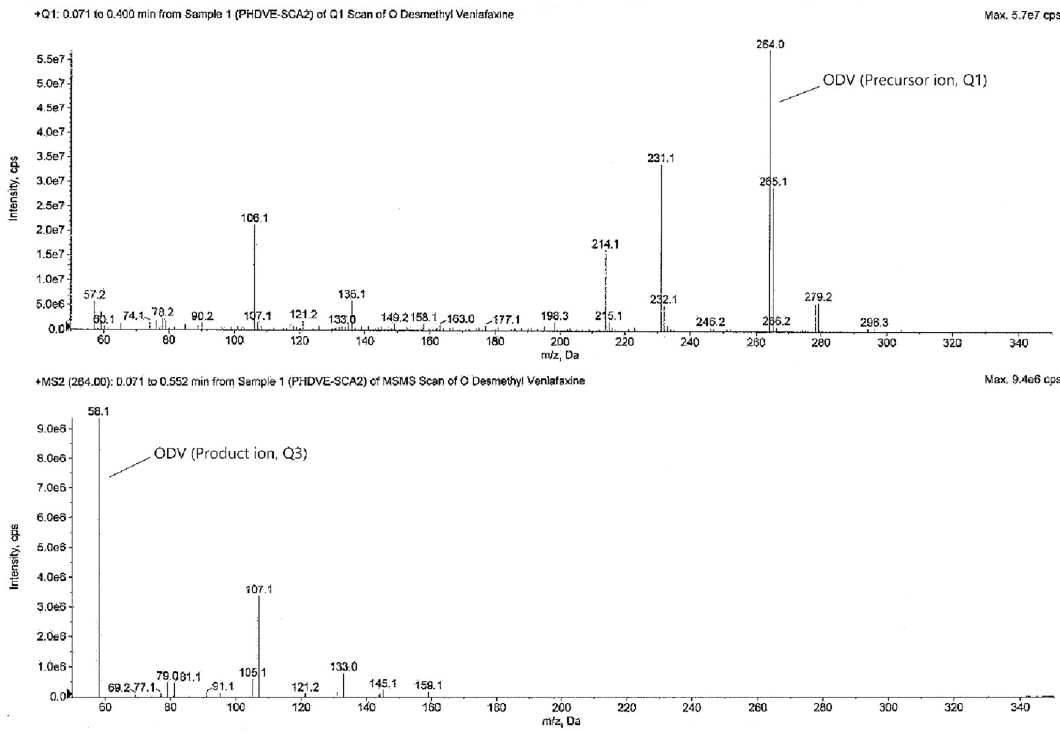
Figure 4. MRM mass spectra and fragmentation of O -desmethylvenlafaxine.